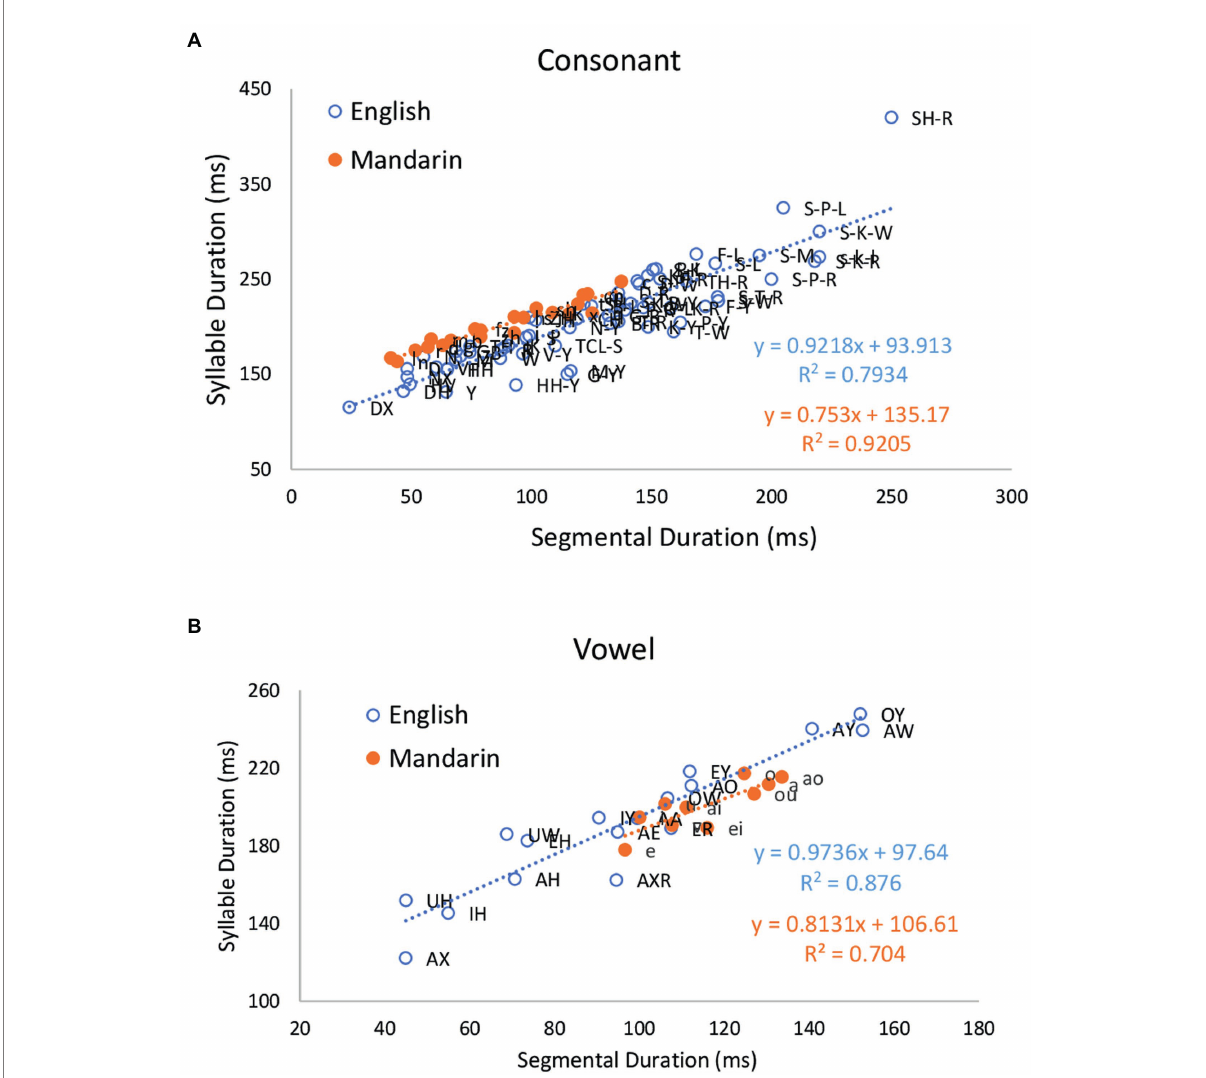
FIGURE 2 Duration of CV syllable in American English and Mandarin as a function of intrinsic duration of consonants (A) and vowels (B) , together with linear regression lines and Pearson correlation